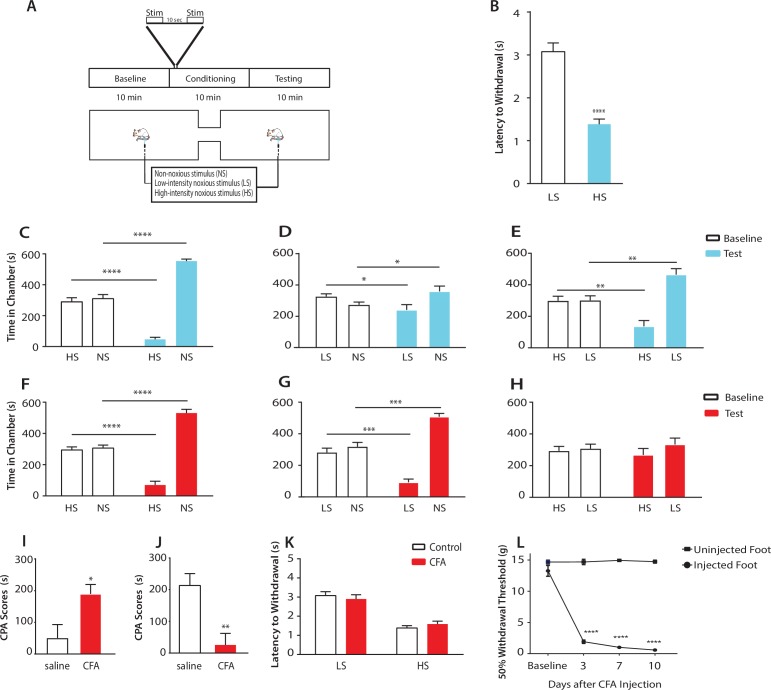
Chronic pain enhances the aversive response to acute pain at anatomically unrelated sites.(A) Schematic for the conditioned place aversion (CPA) test. Each episode of peripheral stimulation lasted until paw withdrawal or in cases of no withdrawal (non-noxious stimulus or NS) a total of 5 s. (B) Latency to paw withdrawal was shorter with higher intensity pain stimulus (HS) than lower intensity stimulus (LS). n = 12; p<0.0001, Student’s t test. (C) During conditioning, rats received HS in one chamber and NS in the other chamber. After conditioning, rats spent less time in the chamber paired with HS during the test phase than at baseline, and more time in the chamber paired with NS. n = 14; p<0.0001, paired Student’s t test. (D) After conditioning with LS and NS in separate chambers, rats spent less time in the chamber paired with LS during the test phase than at baseline, and more time in the chamber paired with NS. n = 14; p=0.0131. (E) After conditioning with HS and LS, rats spent less time in the chamber paired with HS during the test phase than at baseline, and more time in the chamber paired with LS. n = 10; p=0.0012. (F) 10 days after CFA treatment, rats underwent conditioning by receiving HS stimulation of the uninjected paw in one chamber and NS stimulation of the same paw in the other chamber. During the test phase, rats spent less time in the chamber paired with HS than at baseline, and more time in the chamber paired with NS. n = 9; p<0.0001; paired Student’s t test. (G) After CFA treatment, after conditioning with LS and NS in separate chambers, rats spent less time in the chamber paired with LS stimulation of the uninjected paw during the test phase than at baseline, and more time in the chamber paired with NS. n = 9; p=0.0002. (H) After CFA treatment, rats could not differentiate between HS and LS treatments of the uninjected paws on the CPA test. n = 13; p=0.4923. (I) CFA treatment resulted in increased aversive response to LS. Rats were conditioned with LS and NS, and the CPA or aversion score was calculated by subtracting the amount of time rats spent during the test phase from baseline in the LS-paired chamber (see Materials and methods section). CPA scores for CFA-treated rats were significantly higher than saline control. n = 9–10; p=0.0179, unpaired Student’s t test. (J) After CFA treatment, rats could not distinguish between HS and LS. Rats were conditioned with HS in one chamber and LS in the other chamber. The CPA score for HS was calculated by subtracting the amount of time spent in the HS-paired chamber during the test phase from baseline. CFA-treated rats demonstrated a significant decrease in the CPA score, indicating an inability to distinguish between the aversive values of HS and LS. n = 8–13; p=0.0029, unpaired Student’s t test. (K) CFA treatment did not alter paw withdrawal latency in the uninjected paw. n = 12; p=0.8381, two-way ANOVA with repeated measures and post-hoc Bonferroni test. (L) CFA treatment caused mechanical allodynia in the injected but not uninjected paw. n = 12; p<0.0001. two-way ANOVA with repeated measures and post-hoc Bonferroni test.